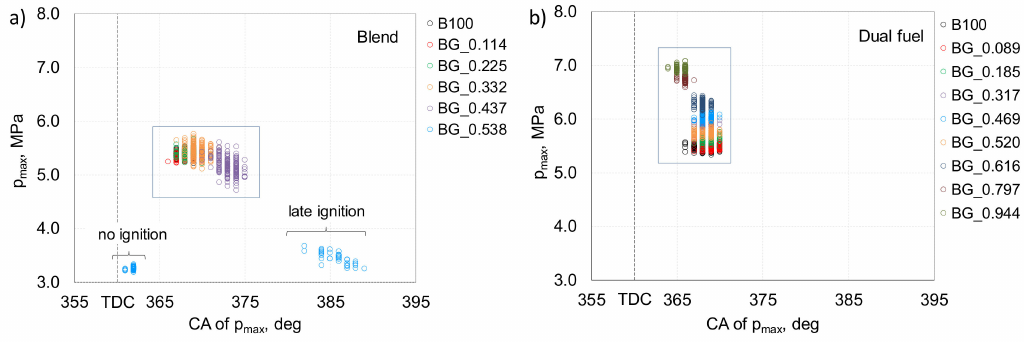
Figure12. ThepositionofthepeakpressureafterTDCforblends( a )anddualfuel( b